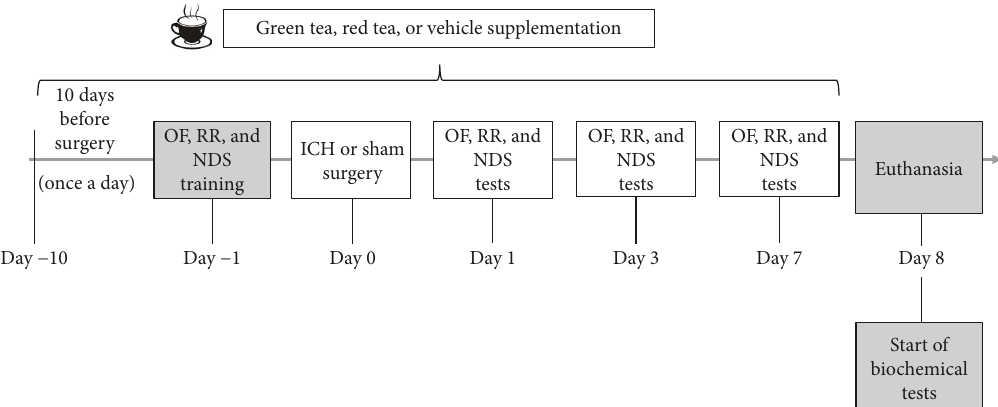
Figure 1: Experimental design. All rats were supplemented with green tea (GT), red tea (RT), or vehicle for 10 days prior to intracerebral hemorrhage (ICH). Twenty-four hours after, the rats were submitted to training in neuromotor tests (open fi eld: OF; rotarod: RR; neurological de fi cit scale: NDS). In the following day (day 0), the rats were submitted to ICH or sham surgery following by 24 hours of recovery. On days 1, 3, and 7 after surgery, the rats were submitted to neuromotor tests. During all behavioral testing days, the rats continued to receive supplementation with tea or vehicle. On the eighth day, the rats were euthanized and the striatum were isolated to biochemical